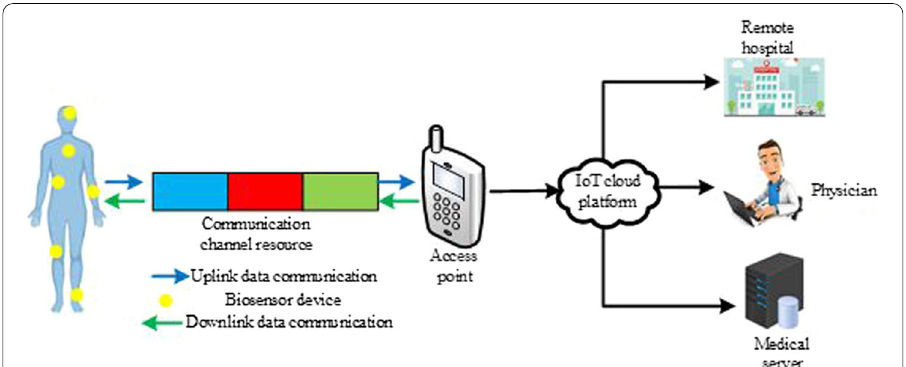
Fig. 1 An illustration of data transmissions in a WBAN